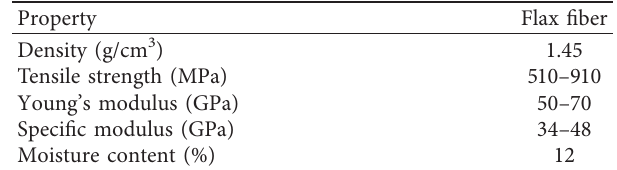
Table 2: Characteristics of flax fiber.